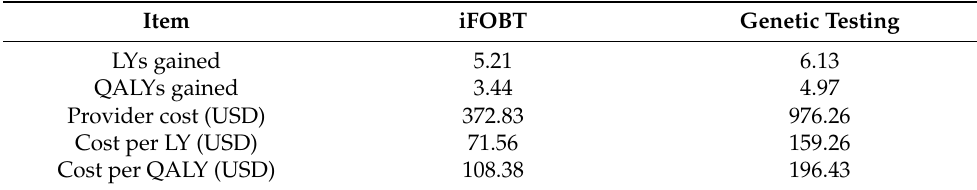
Table 5. Cost-effectiveness analysis of genetic